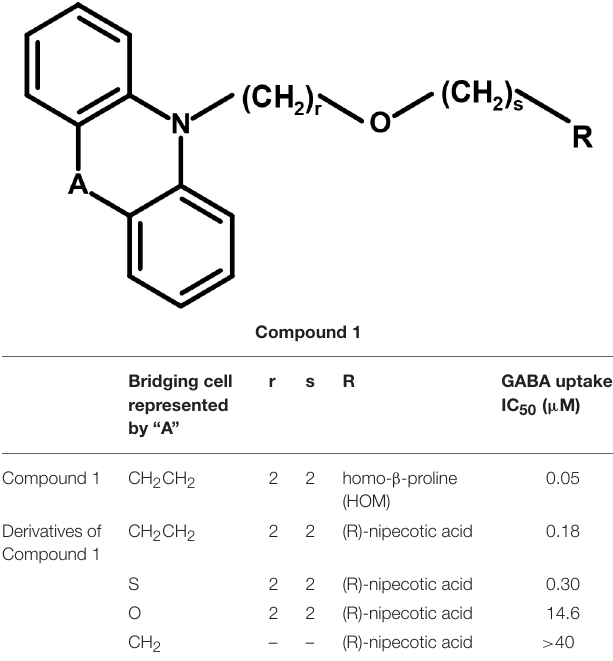
( Table 3 ). In addition, in vitro analysis of their